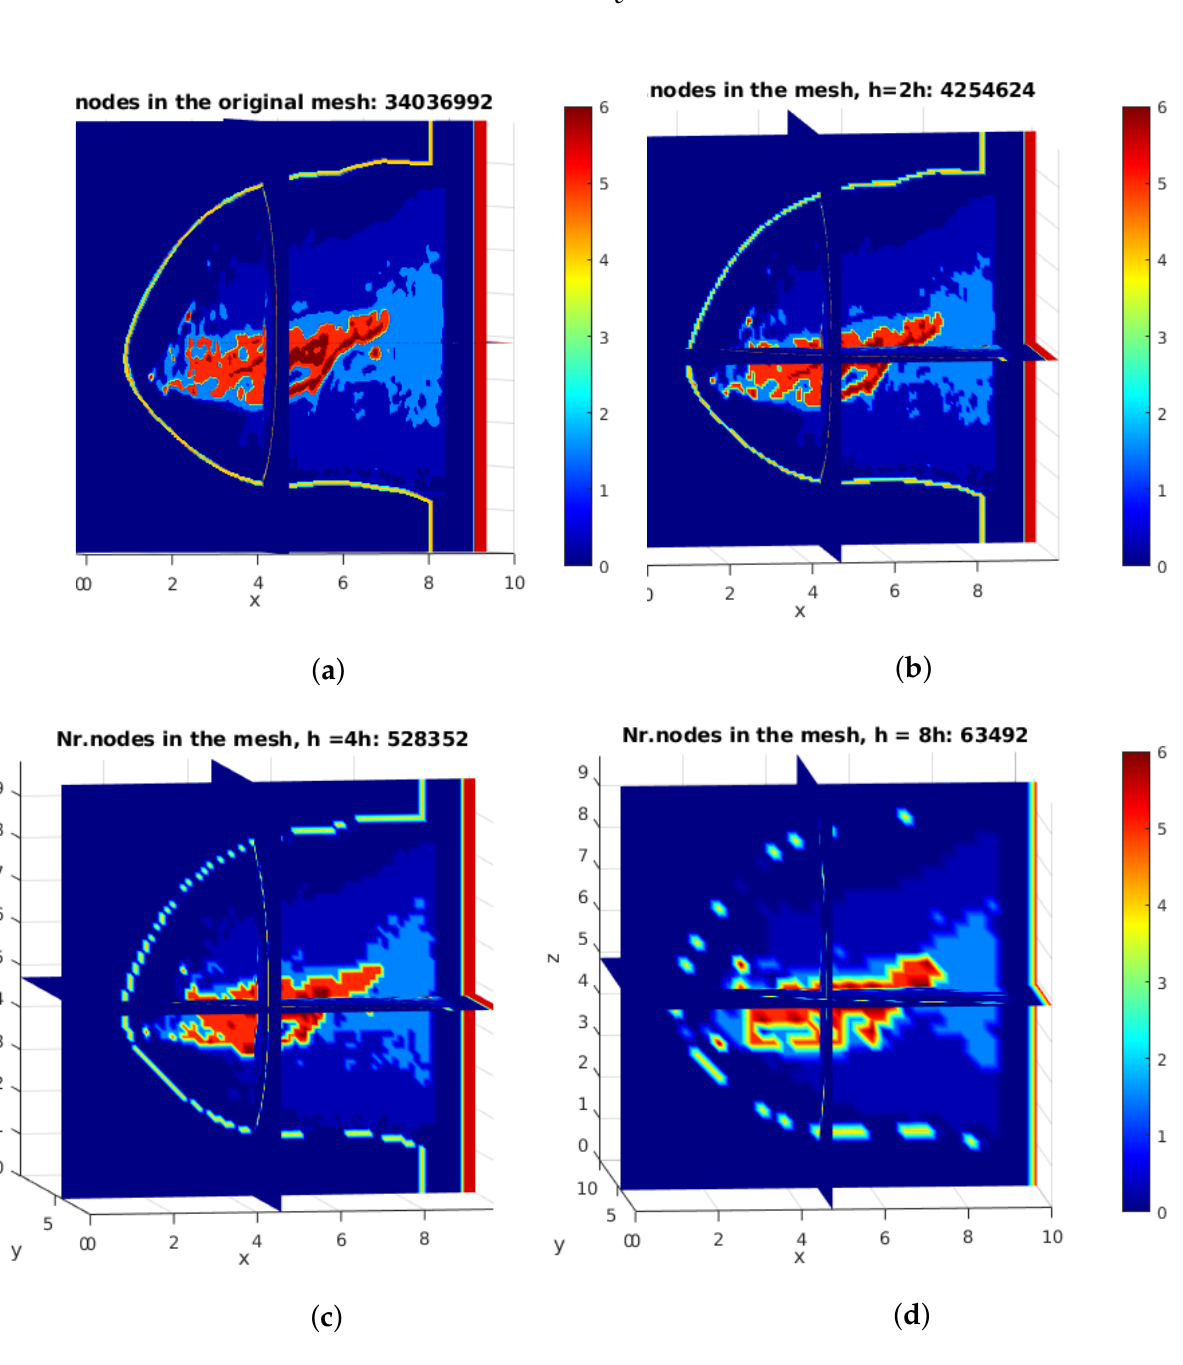
Figure 5. Spatial distribution of realistic ultrawideband dielectric properties of 3D breast phantom of database [1] developed at the Department of Electrical and Computer Engineering at the University of Wisconsin-Madison, USA. ( a ) shows original values of σ (S/m) at 6 GHz for object ID _012204 of database [1]. ( b – d ) present sampled versions of σ (S/m). Figures are produced by MATLAB code provided at